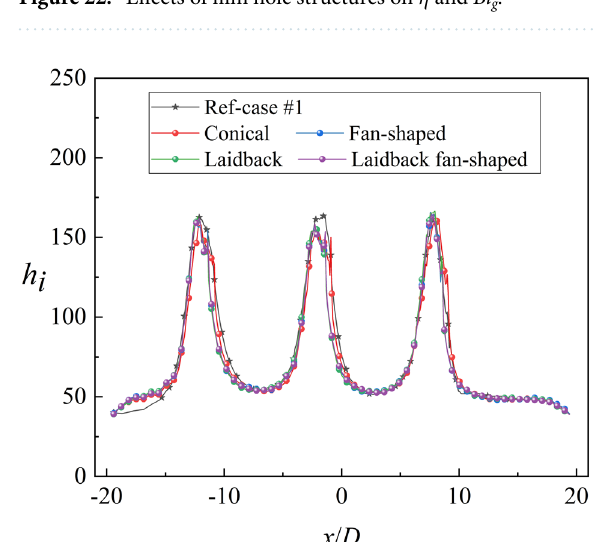
Figure 22. Effects of film hole structures on η and Bi g .